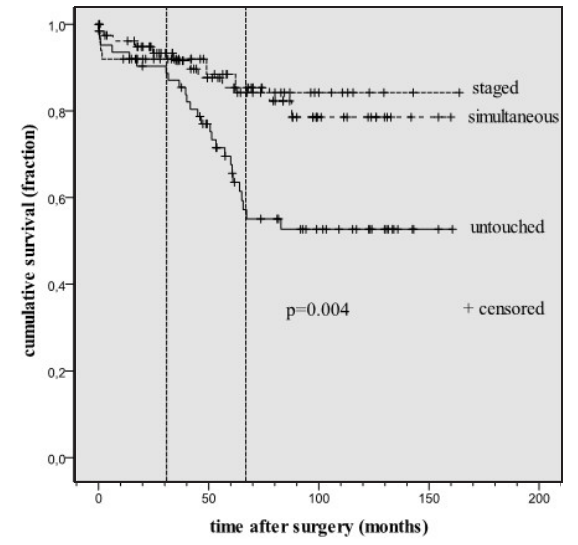
excluded, event-free survival differences between groups were lost (Figure 2, P =0.740). If cardiovascular events were excluded, the negative dissociation of the only CABG group re-emerged (Figure 3, P =0.004). Event-free survival deviation determined by vertical lines in Figure 3 begins in the postoperative 34th month ( P -value > 0.05 at this point) and continues until the 66 th month postoperatively. In the only CABG group, 34 patients, whose degree of carotid stenosis and/or symptoms increased, underwent CEA in our hospital or in other local hospitals during the follow-up period. Two patients had stroke during this time and a few patients have still some atypical neurological symptoms.